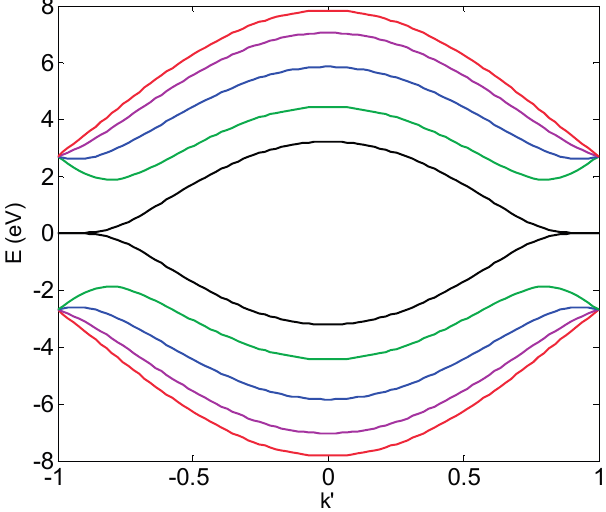
Figure 2. Typical band structure for A-GNRs vs. normalized wavenumber ( a ) metallic; and ( b ) semi-conducting.